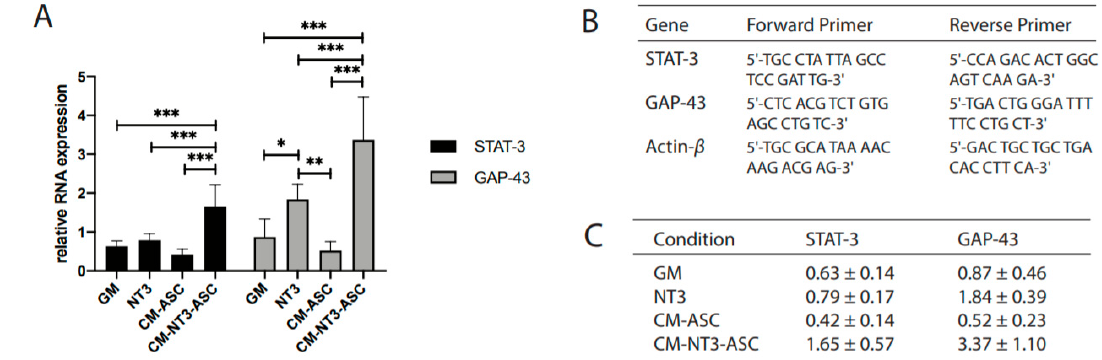
Figure 4. Transcriptional analysis of DRG explants treated with di ff erential stimuli. A ) Analysis of STAT-3 and GAP-43 mRNA expression by qRT-PCR, B ) Primer sequences used for reverse transcription with polymerase chain reaction, and C ) Quantitative measurements of mRNA expression. Expression values are relative to β -actin expression and are therefore in arbitrary units, shown as the mean ± SD of n = 9. Significant di ff erences are indicated as * p < 0.05, ** p < 0.01, and *** p < 0.001.